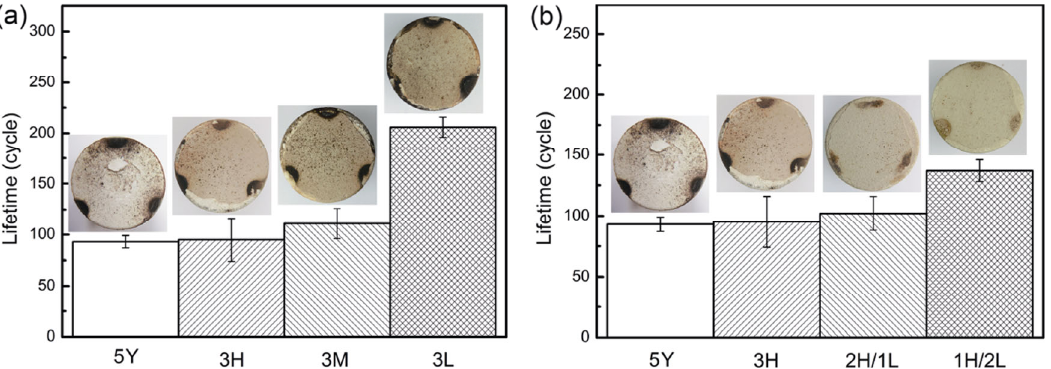
Fig. 61 Lifetime of newly designed TBCs under gradient thermal cyclic tests: (a) overall modulus reduction design and (b) sublayer structure design. Reproduced with permission from Ref. [353], © Elsevier B.V. 2019; Ref. [354], © Published by Elsevier Ltd.